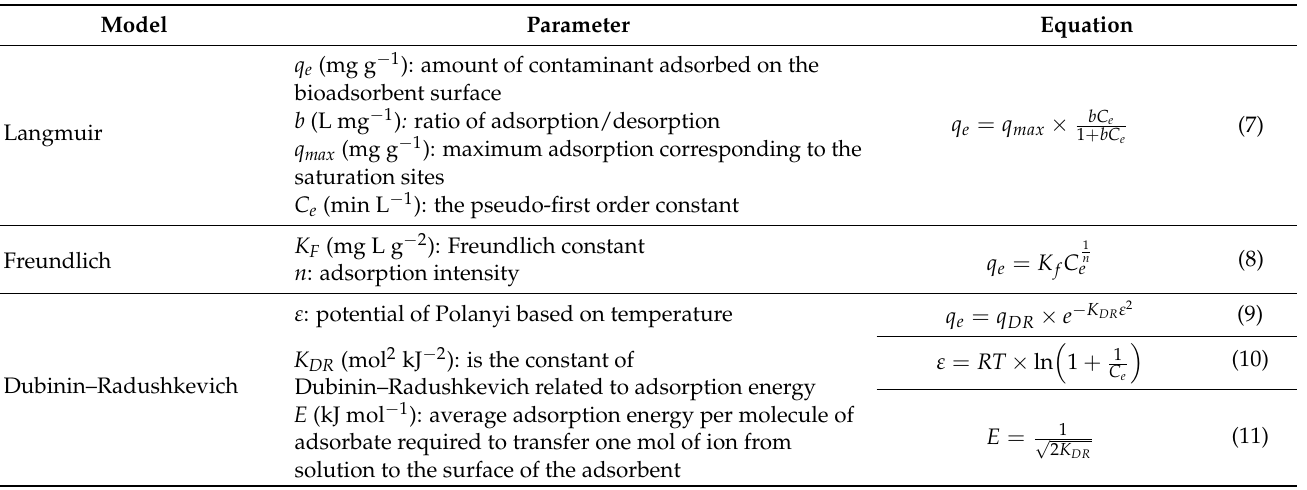
Table 3. Non-linear isotherm